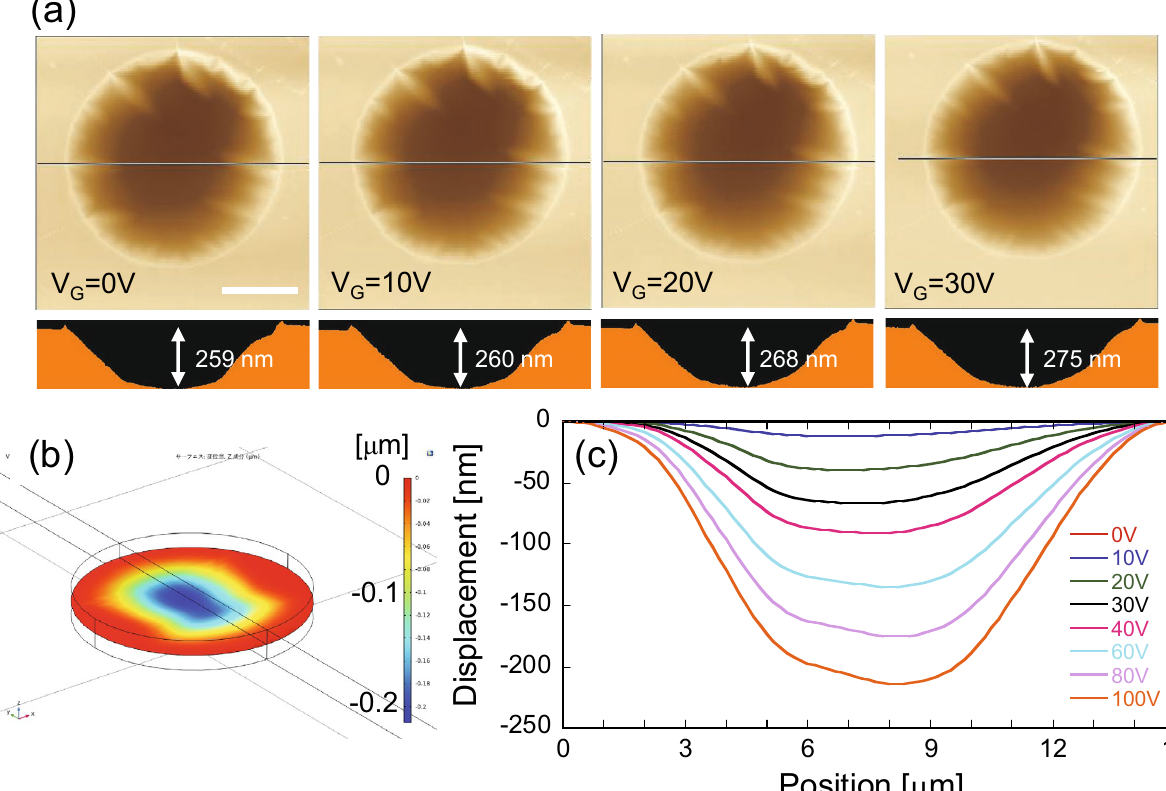
Figure 5. ( a ) Top and cross-sectional views of AFM images of the graphene drum for DEVICE 2 at various applied voltages V G . ( b ) Model of the graphene drum used for the finite element calculation (COMSOL) merged with the calculated displacement at V G = 100 V. ( c ) FEM results of the displacement as a function of the drum position at various